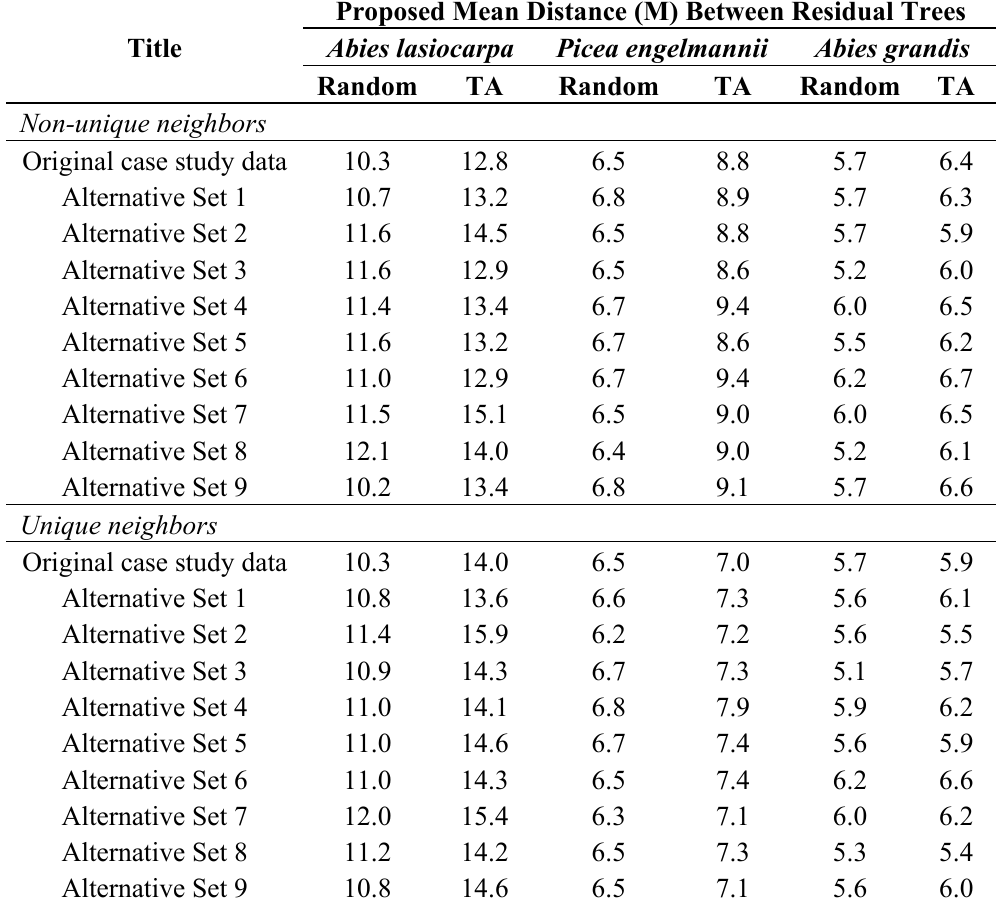
Table 7. Results of the application of threshold accepting to a tree-level harvest schedule of an uneven-aged mixed-conifer stand in eastern Oregon (western United States), for the original and nine other alternative representations of the case study forest. The data arose from 100 runs of the model for each